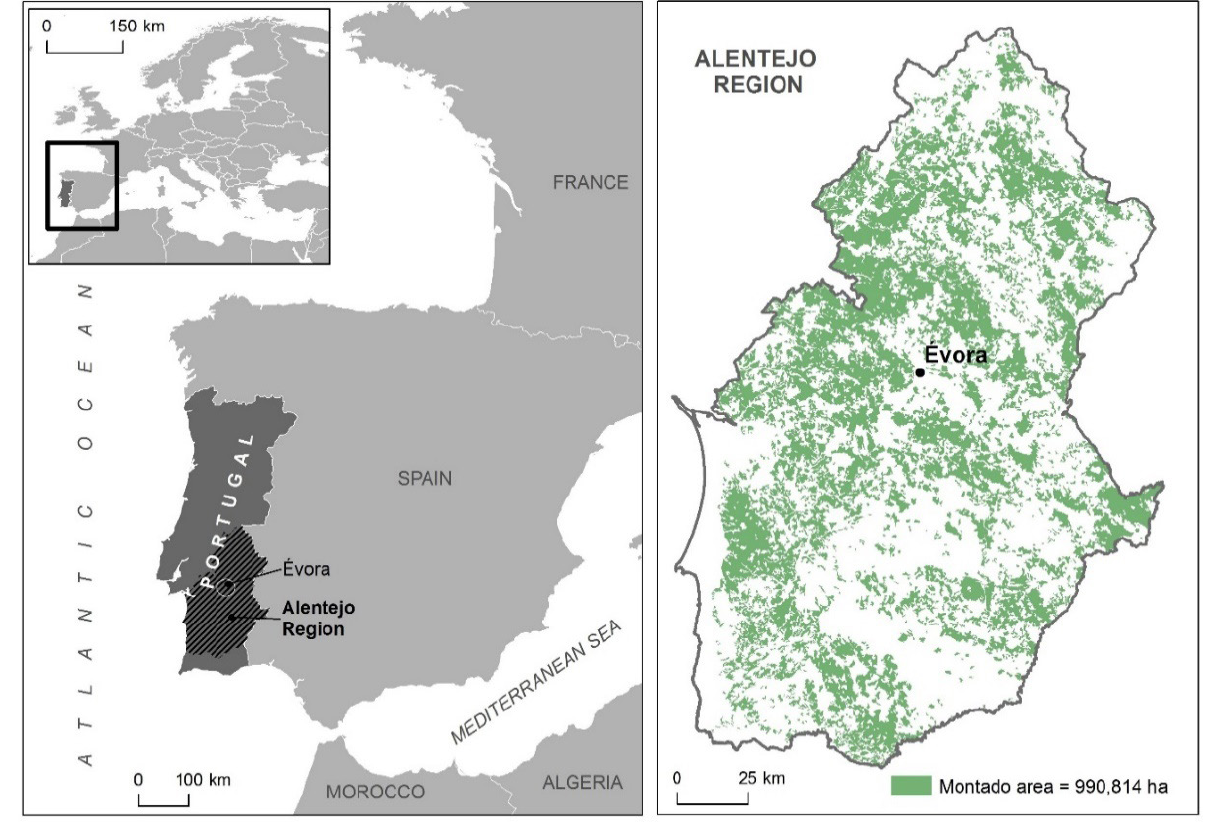
Figure 3 : The location and coverage of the Montado in the Alentejo region (2006 data; source: (Godinho et al.